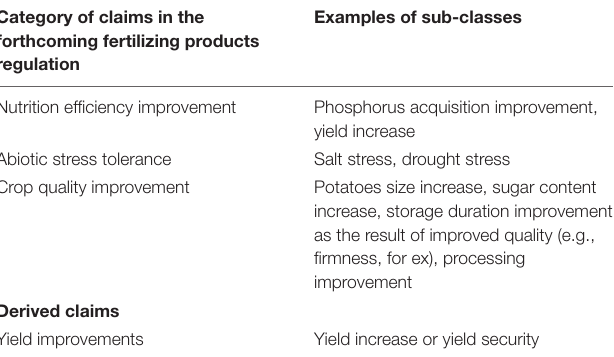
TABLE 2 | Categories of biostimulant claims and examples of sub-claims. Category of claims in the forthcoming fertilizing